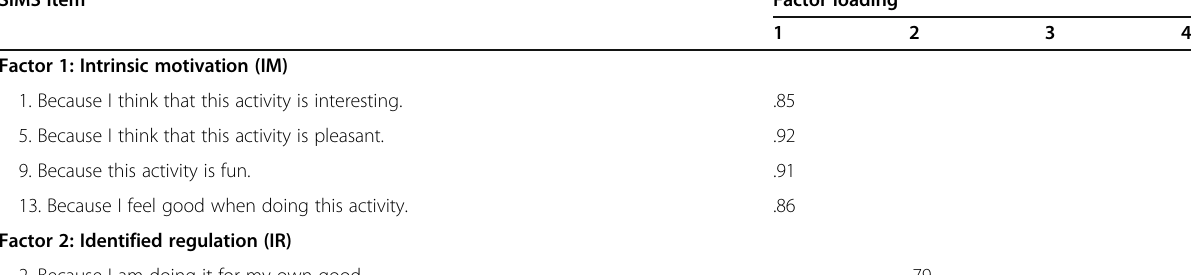
Table 3 Results from confirmatory factor analysis of the Situational Motivation Scale (SIMS) questionnaire SIMS item